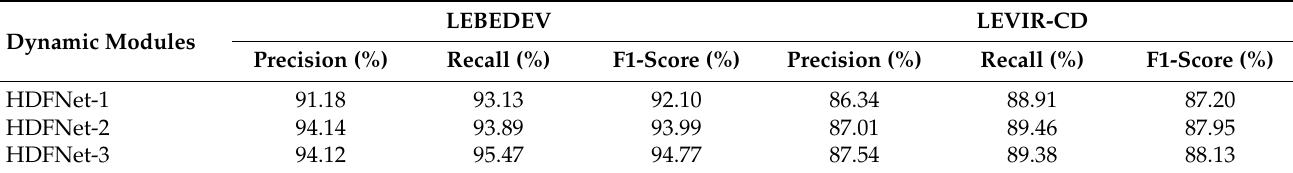
Table 6. Ablation study of Dynamic Modules numbers.